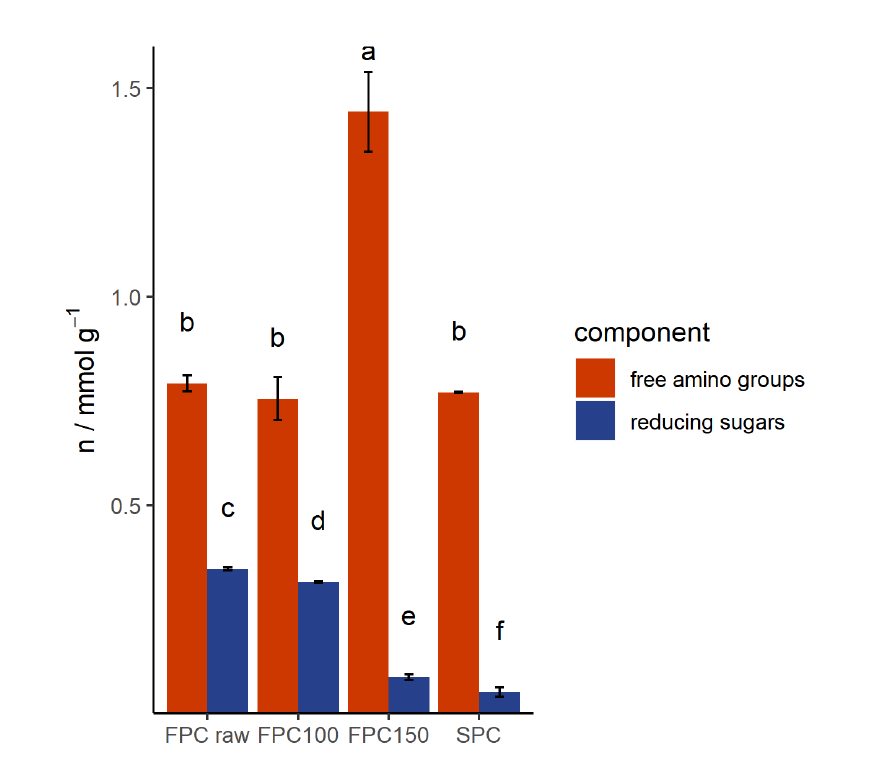
Figure 5. Number of reducing sugars and free amino groups in mmolg − 1 dry matter of dry-heated and non-dry-heated FPC and commercial SPC. n = 3. The number of reducing sugars decreased with increasing dry-heating temperature, while the number of free amino groups increased after dry-heating at 150 ◦ C. SPC is shown as an industry